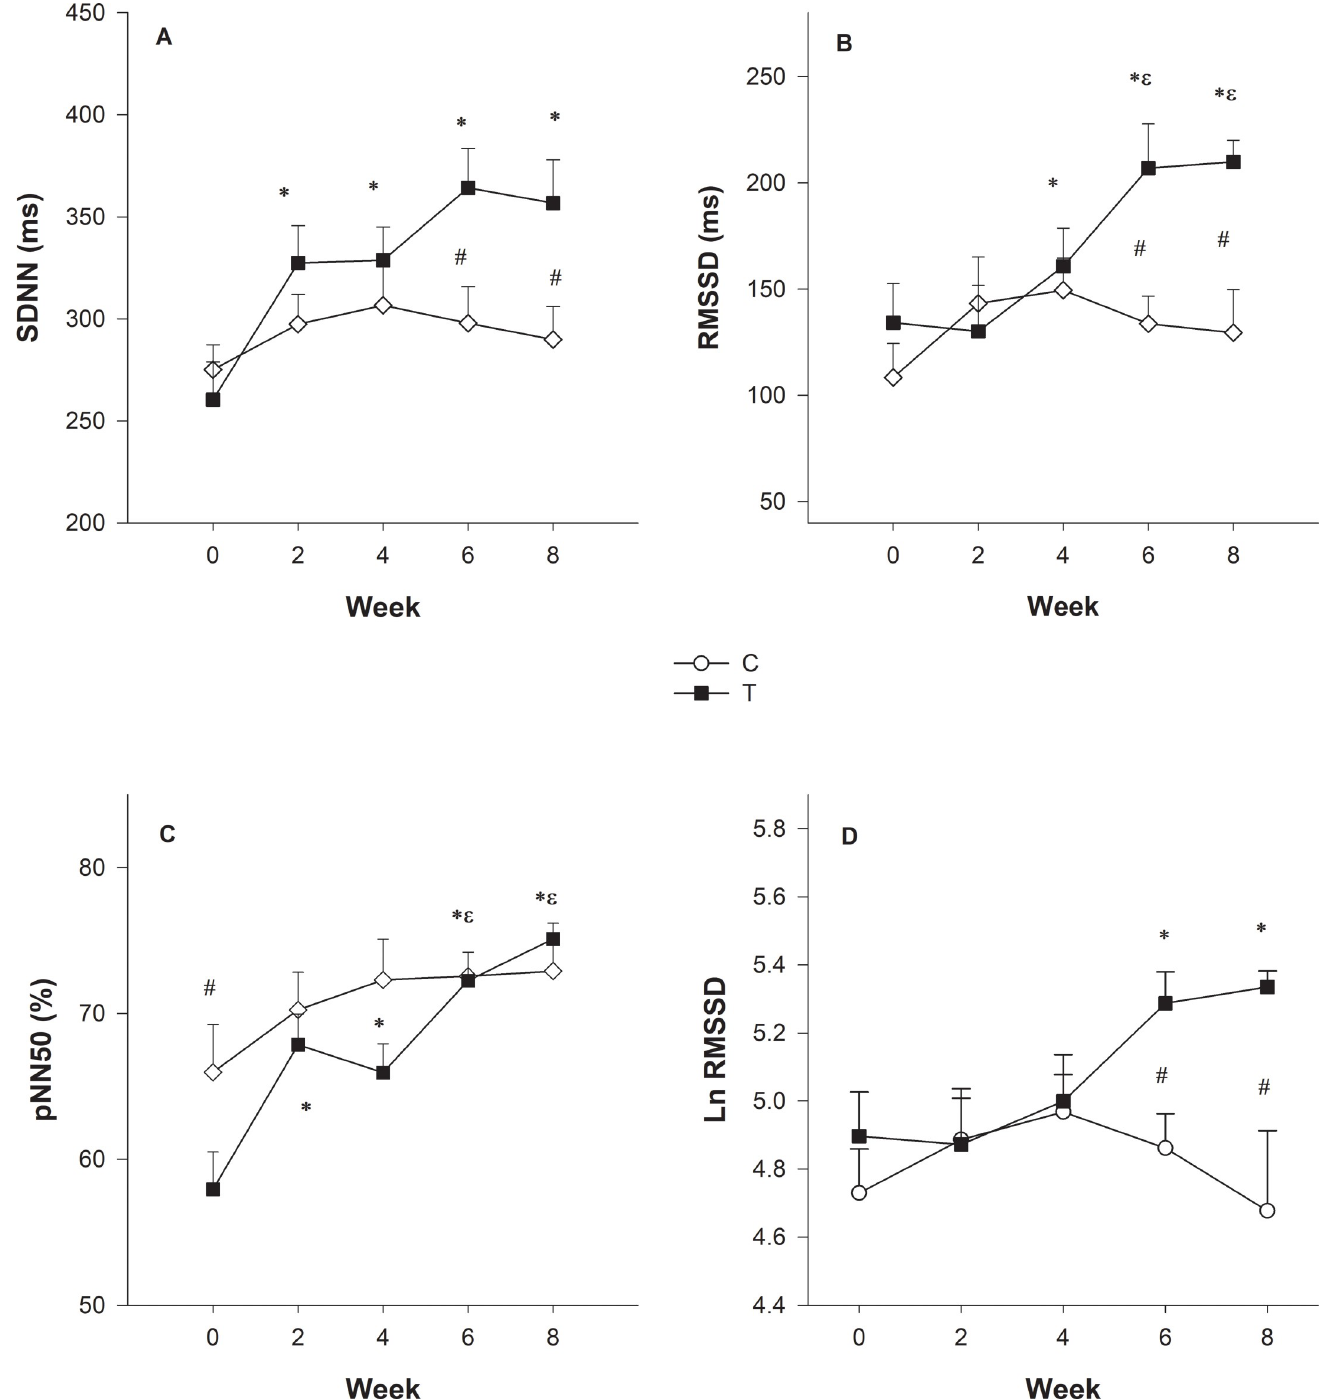
Fig 5. Changes in time-domain measures on heart rate variability (HRV) in dogs undergoing 8-week physical training. SDNN: standard deviation of all normal RR intervals (A); RMSSD: the square root of the mean of the squared differences between adjacent normal RR intervals (B); pNN50: percentage of differences between adjacent normal RR intervals that are > 50 ms (C); LnRMSSD: natural logarithm of the square root of the mean sum of the squared differences between R–R intervals (D). Bars are standard errors. # Indicates difference between groups; � Indicates difference in relation to week 0; ε difference in relation to week 2 and 4 (p <